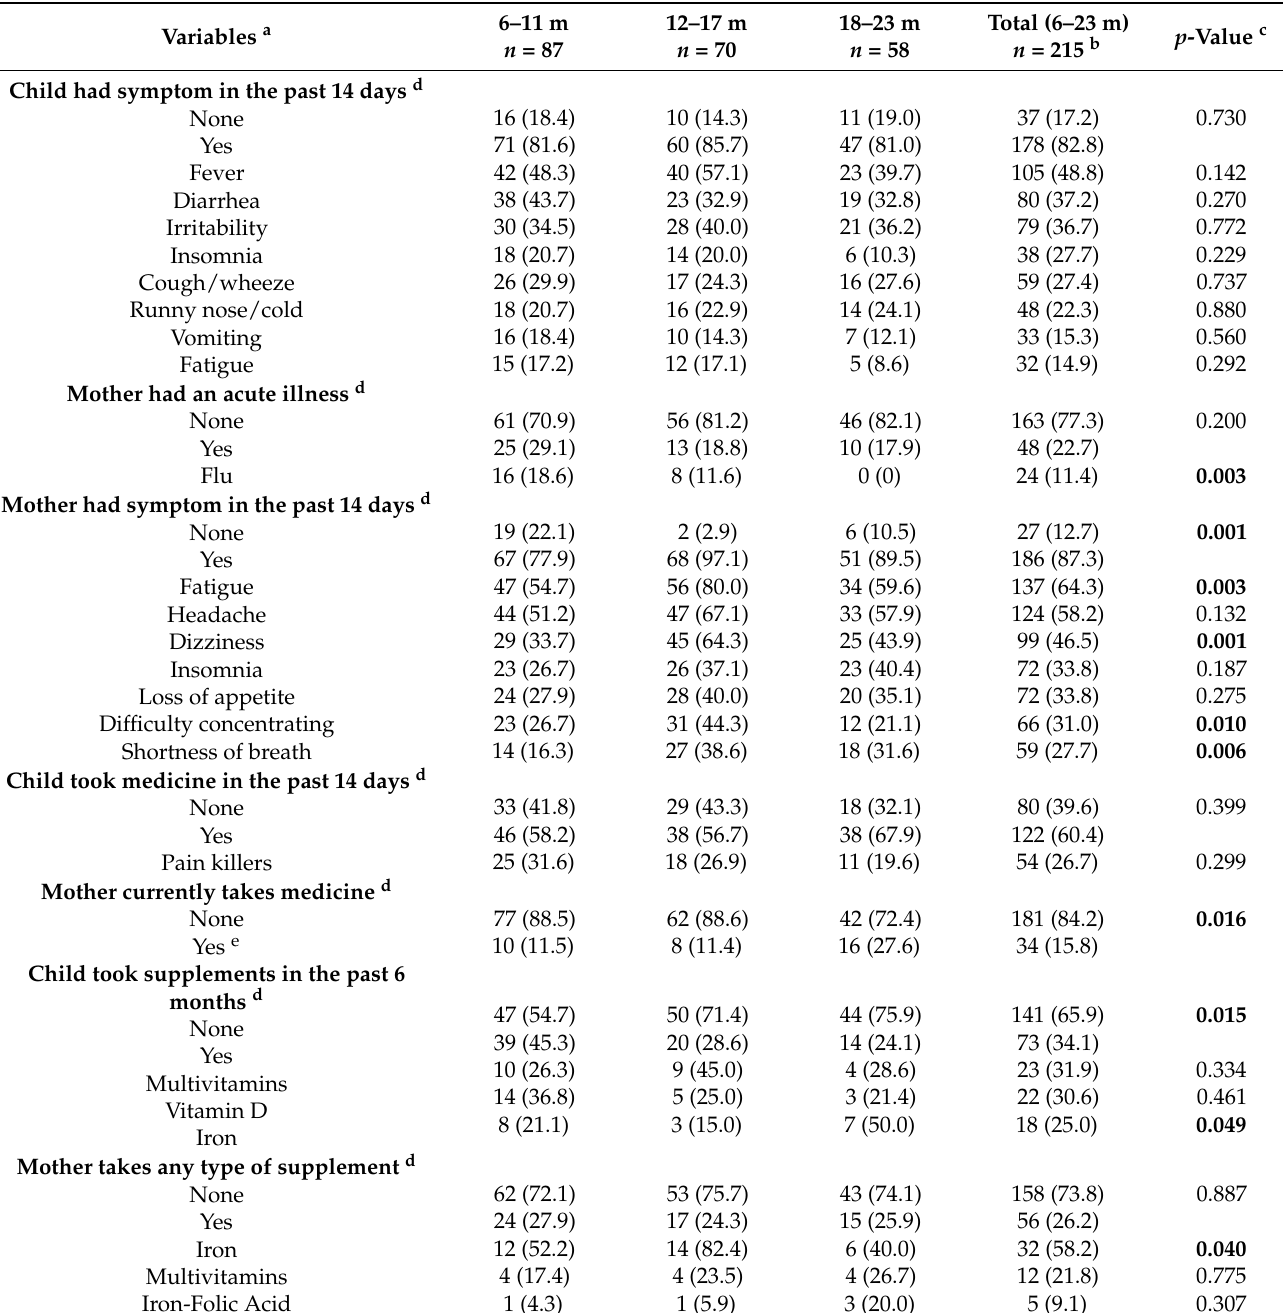
Table 3. Health status and supplements use of Syrian refugee children aged 6 to 23 months and their